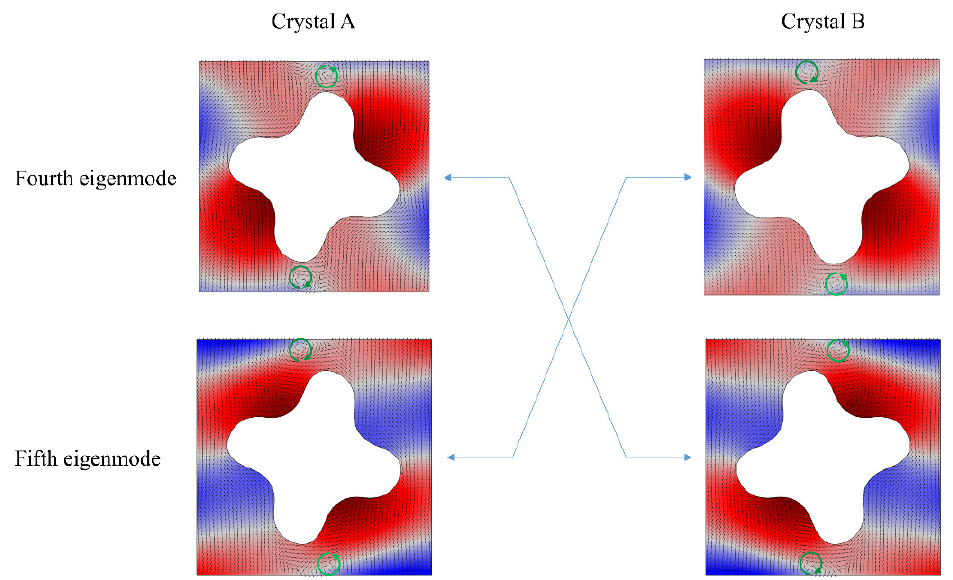
Figure 2. An illustration of band inversion of a pair of valley-like insulators after the break of mirror symmetries near the original Dirac point. Accompanied with the reopen of the degenerate point, the fourth eigenmode of crystal A is exchanged with the fifth eigenmode of crystal B. The typical vortex feature can be observed in the time-averaged Poynting vectors marked with additional green arrows.